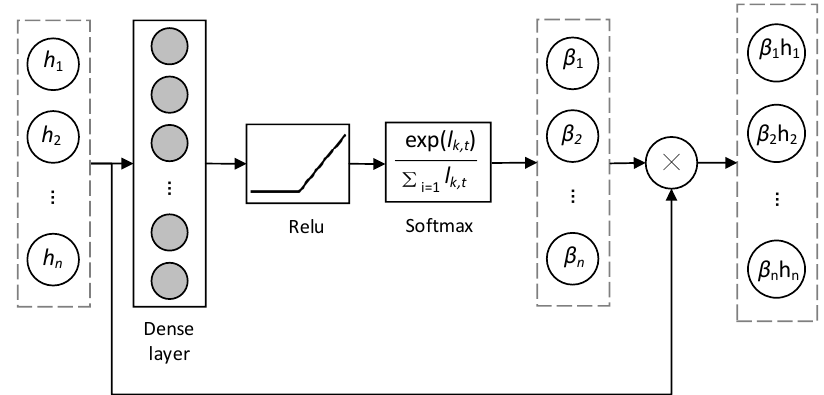
Figure 3. Architecture of the temporal attention mechanism.